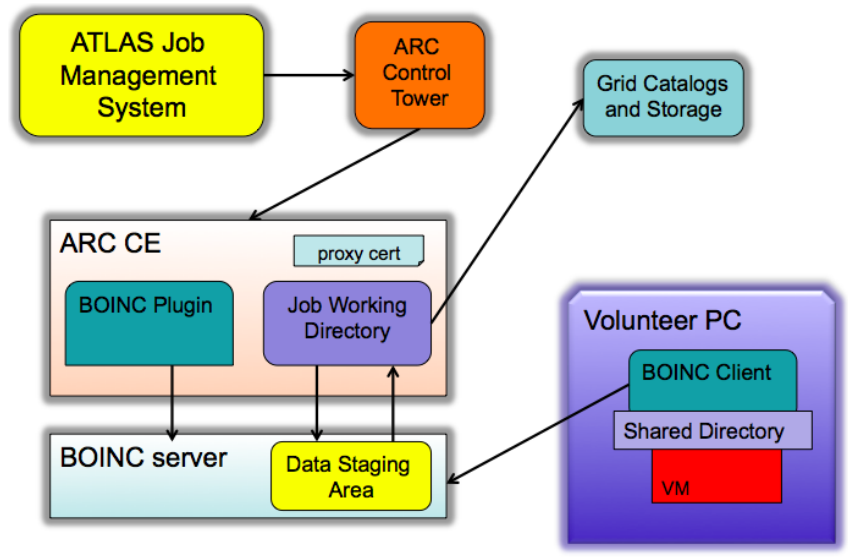
Figure 3: Architecture of ATLAS@Home.